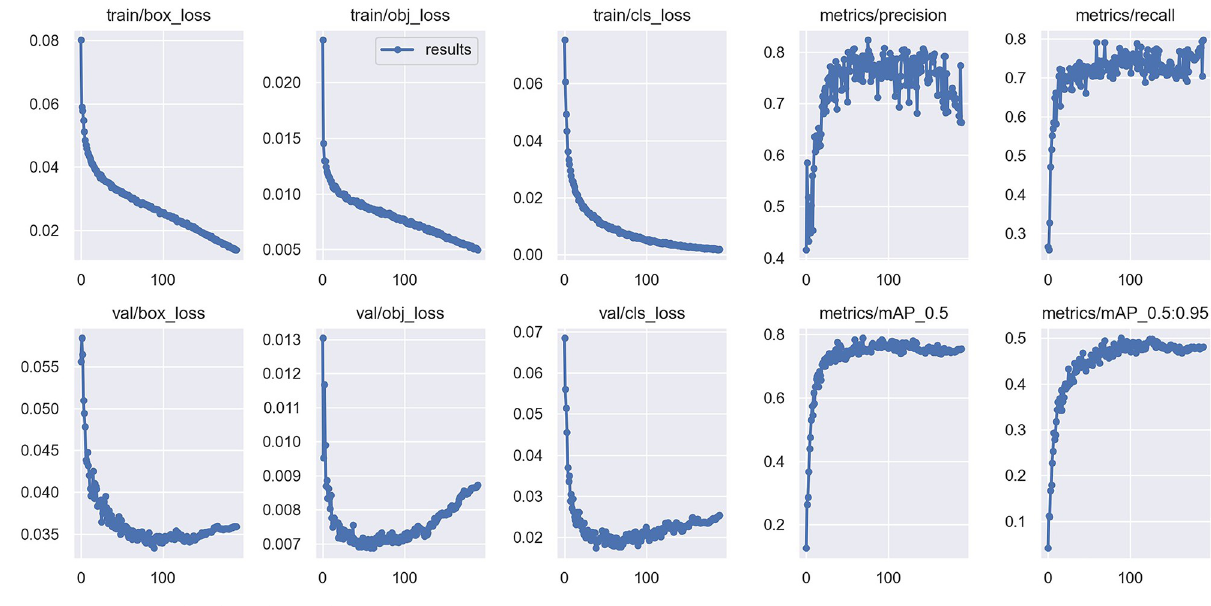
Fig 6. Training results of our designed